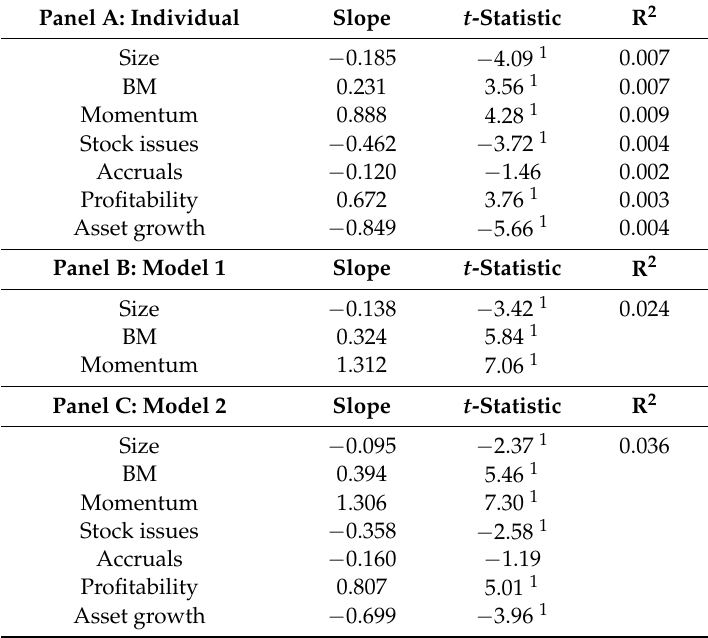
Table 2. Fama and MacBeth (1973) Cross-Sectional Regressions. Panel A: Individual Slope t